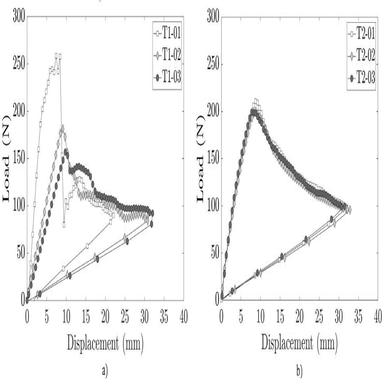
DCB load-displacement curves for (a) rigid adhesive samples and (b) flexible adhesive samples.